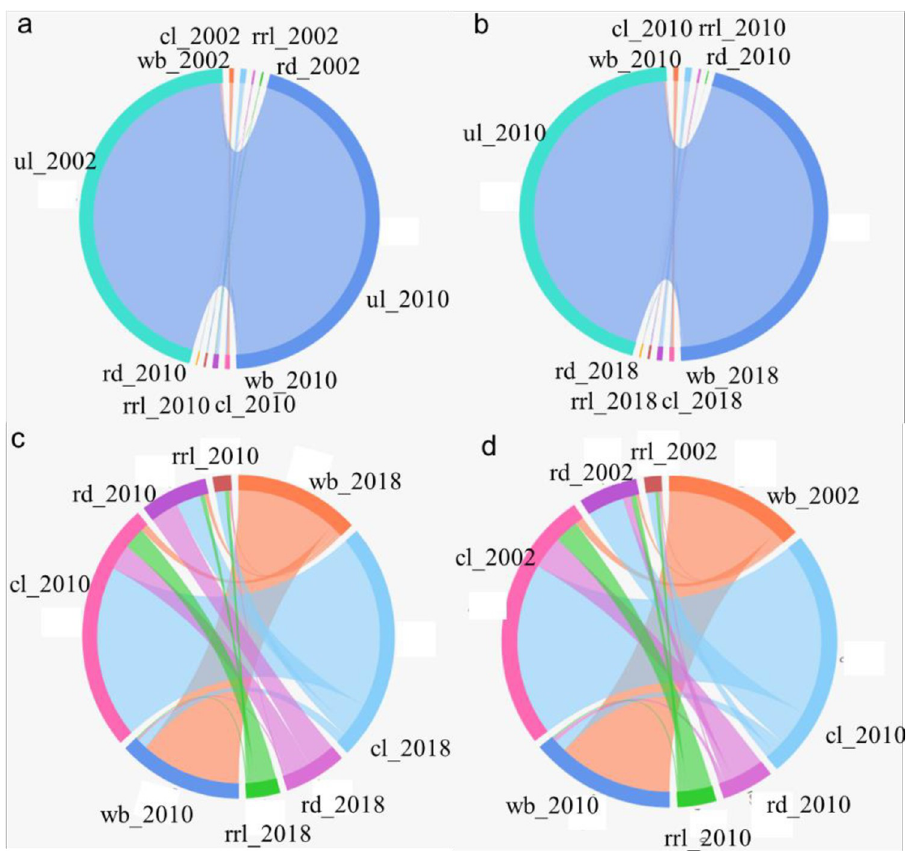
Fig 10. Land use conversion from 2002 to 2018 in QPT. Note: Cropland (cl), rrl (rural residential land), rd (road), ul (unused land), wb (water body).